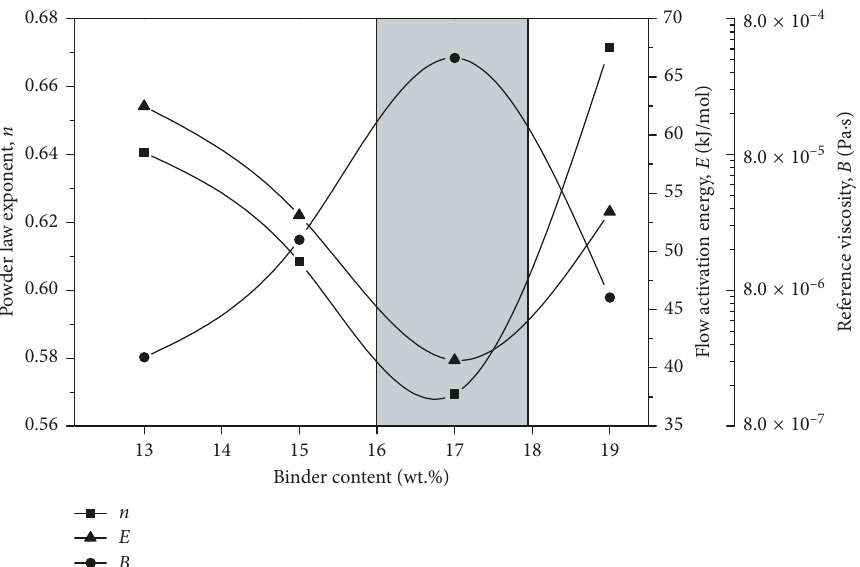
Figure 6: Determination of the critical binder content region.